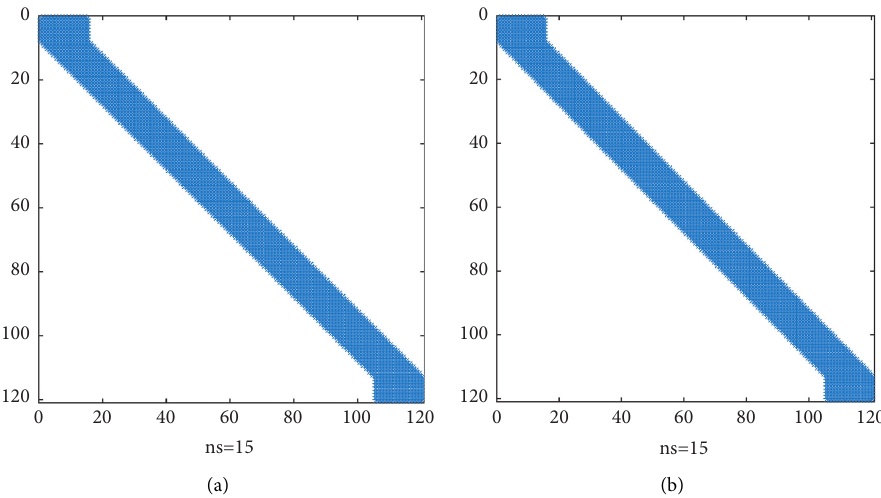
Figure 1: Sparsity pattern of matrices α ( 1 ) (a) and α ( 2 ) (b) for N � 100 and n